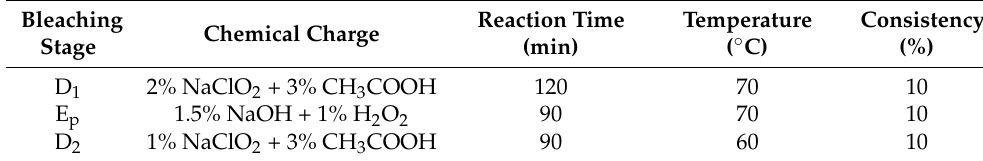
Table 1. The stages of bleaching condition for CNFs isolation from pulped carpet wastes. Bleaching Stage